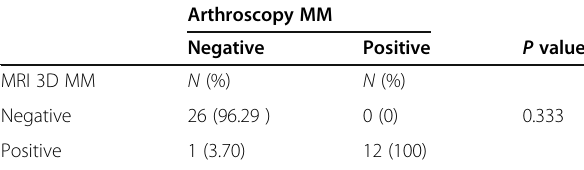
Table 5 Arthroscopic findings correlated with MRI protocol B